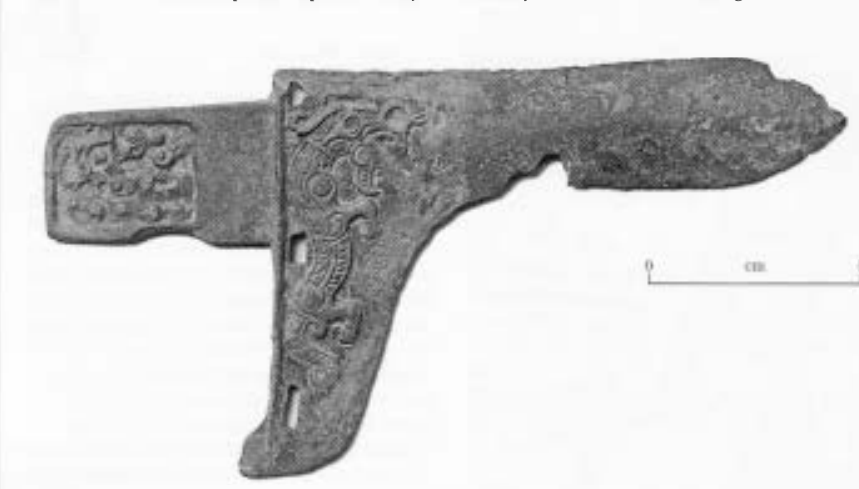
28, Fig. 1 1.9, 1987.] 10,